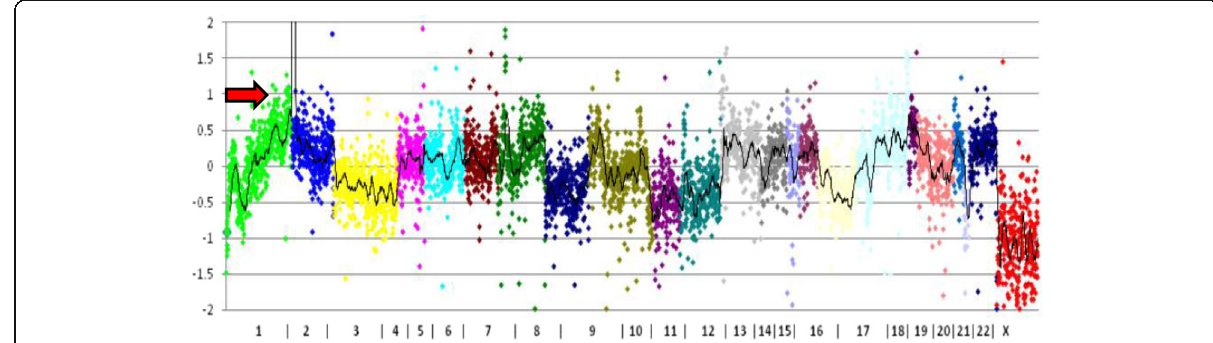
Fig. 4 Plot of copy number variations by chromosomes that are color-coded. Sex chromosomes are excluded from the analysis. The vertical axis is the ratio of number of reads for a specimen to a panel of normal samples in log base 2 scales. A value of 0 denotes no difference from normal (diploid). When the sample contains 100% tumor cells, a value of − 1 is equal to 1 copy loss, and 0.58 is equal to 1 copy gain. The arrow shows the MYCN amplified